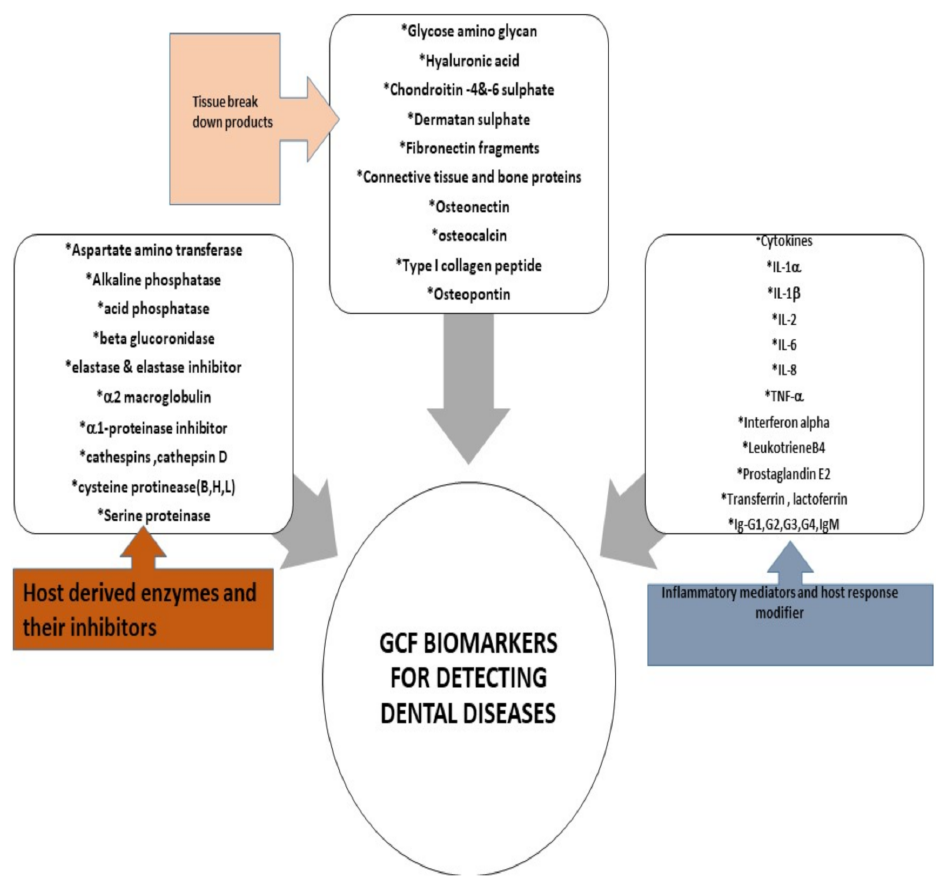
Figure 3. GCF Biomarkers for detecting dental diseases